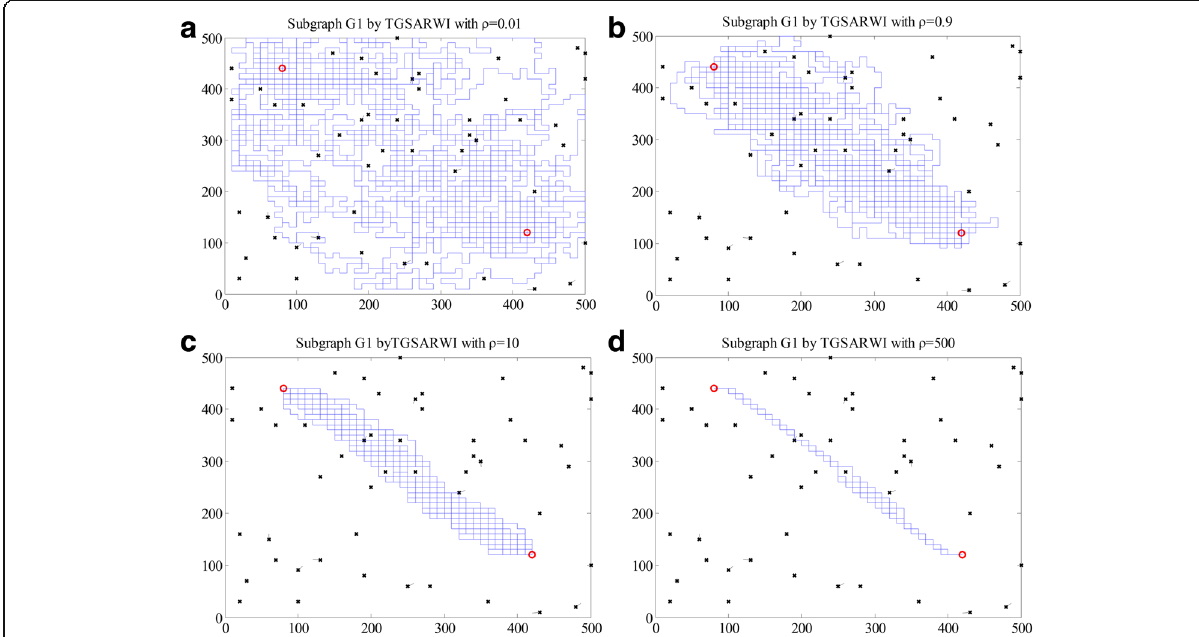
Fig. 7 The sub-network created by TGRWI algorithm with different target guiding factor, where the ρ is set as 0.01, 0.9, 10, and 500, respectively